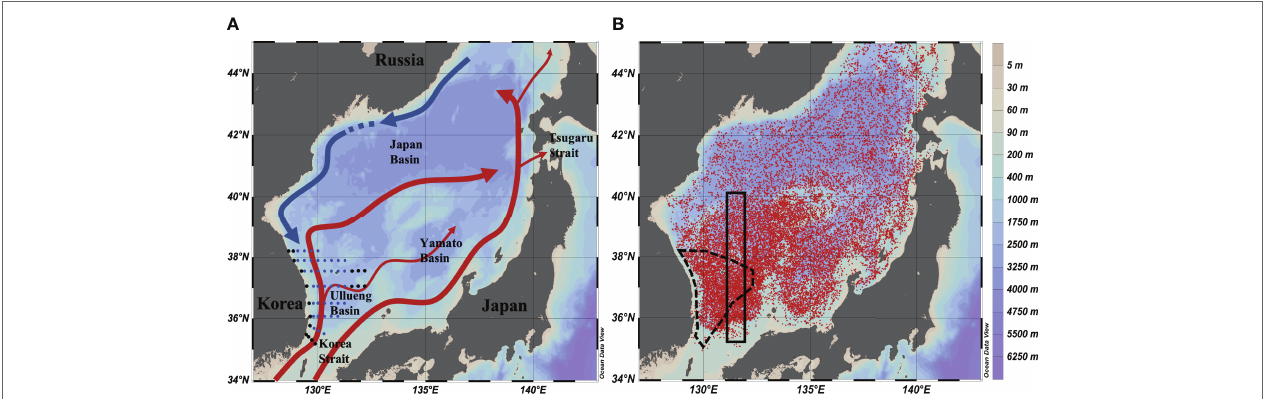
FIGURE 1 | Map of the East Sea and stations for (A) National Institude of Fisheries Science (NIFS) hydrographic data and (B) Argo float (1999–2015). Red and blue arrows in panel (A) denote warm and cold surface currents. All NIFS station data are for thickness comparison with Argo data and the only blue stations are for studying long-term variability of the East Sea Intermediate Water (ESIW). The black solid-line rectangular box shows the area for which Argo data were taken for Figure 2 . The area with dashed lines is for Figure 3 .